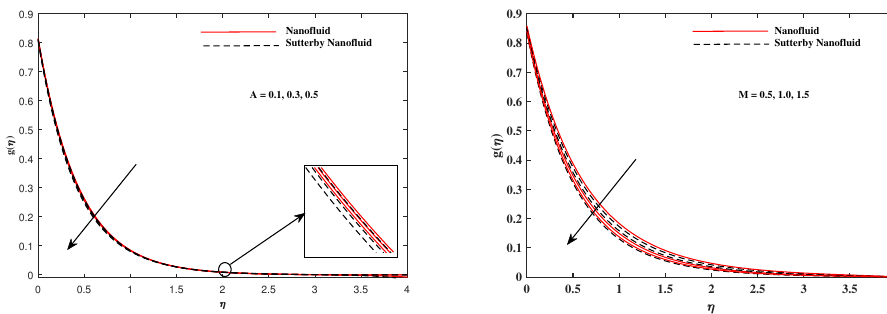
Figure 6. g ( η ) fluctuate in y-direction with A and M .